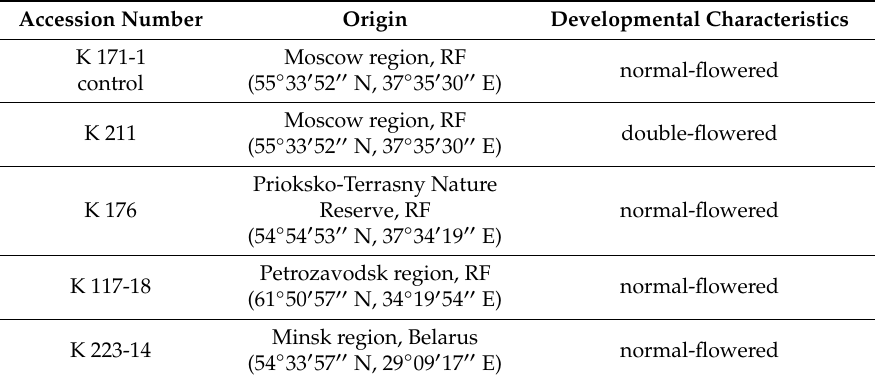
Table 2. List of the studied samples of C. majus